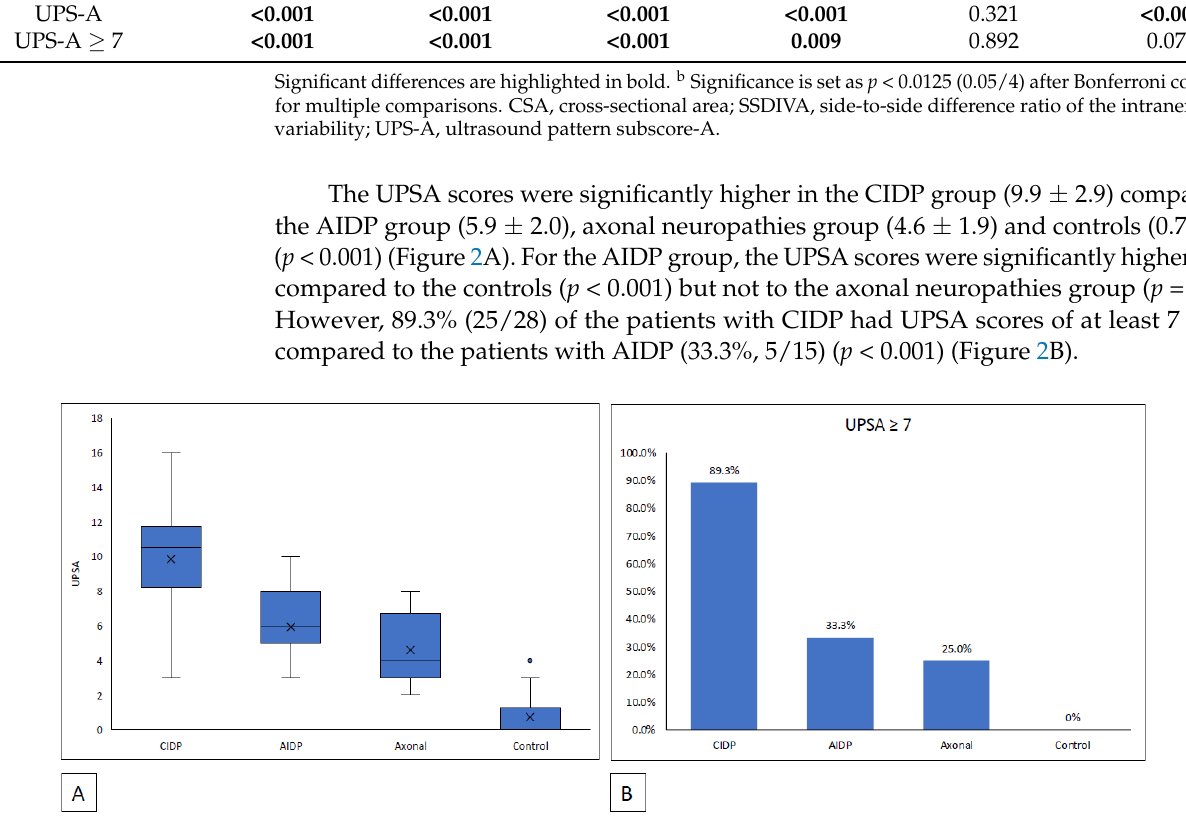
Figure 2. ( A ) Box plots of the mean UPSA scores for CIDP, AIDP, axonal neuropathies and healthy controls. ( B ) Proportion of the groups with UPSA scores of ≥ 7.